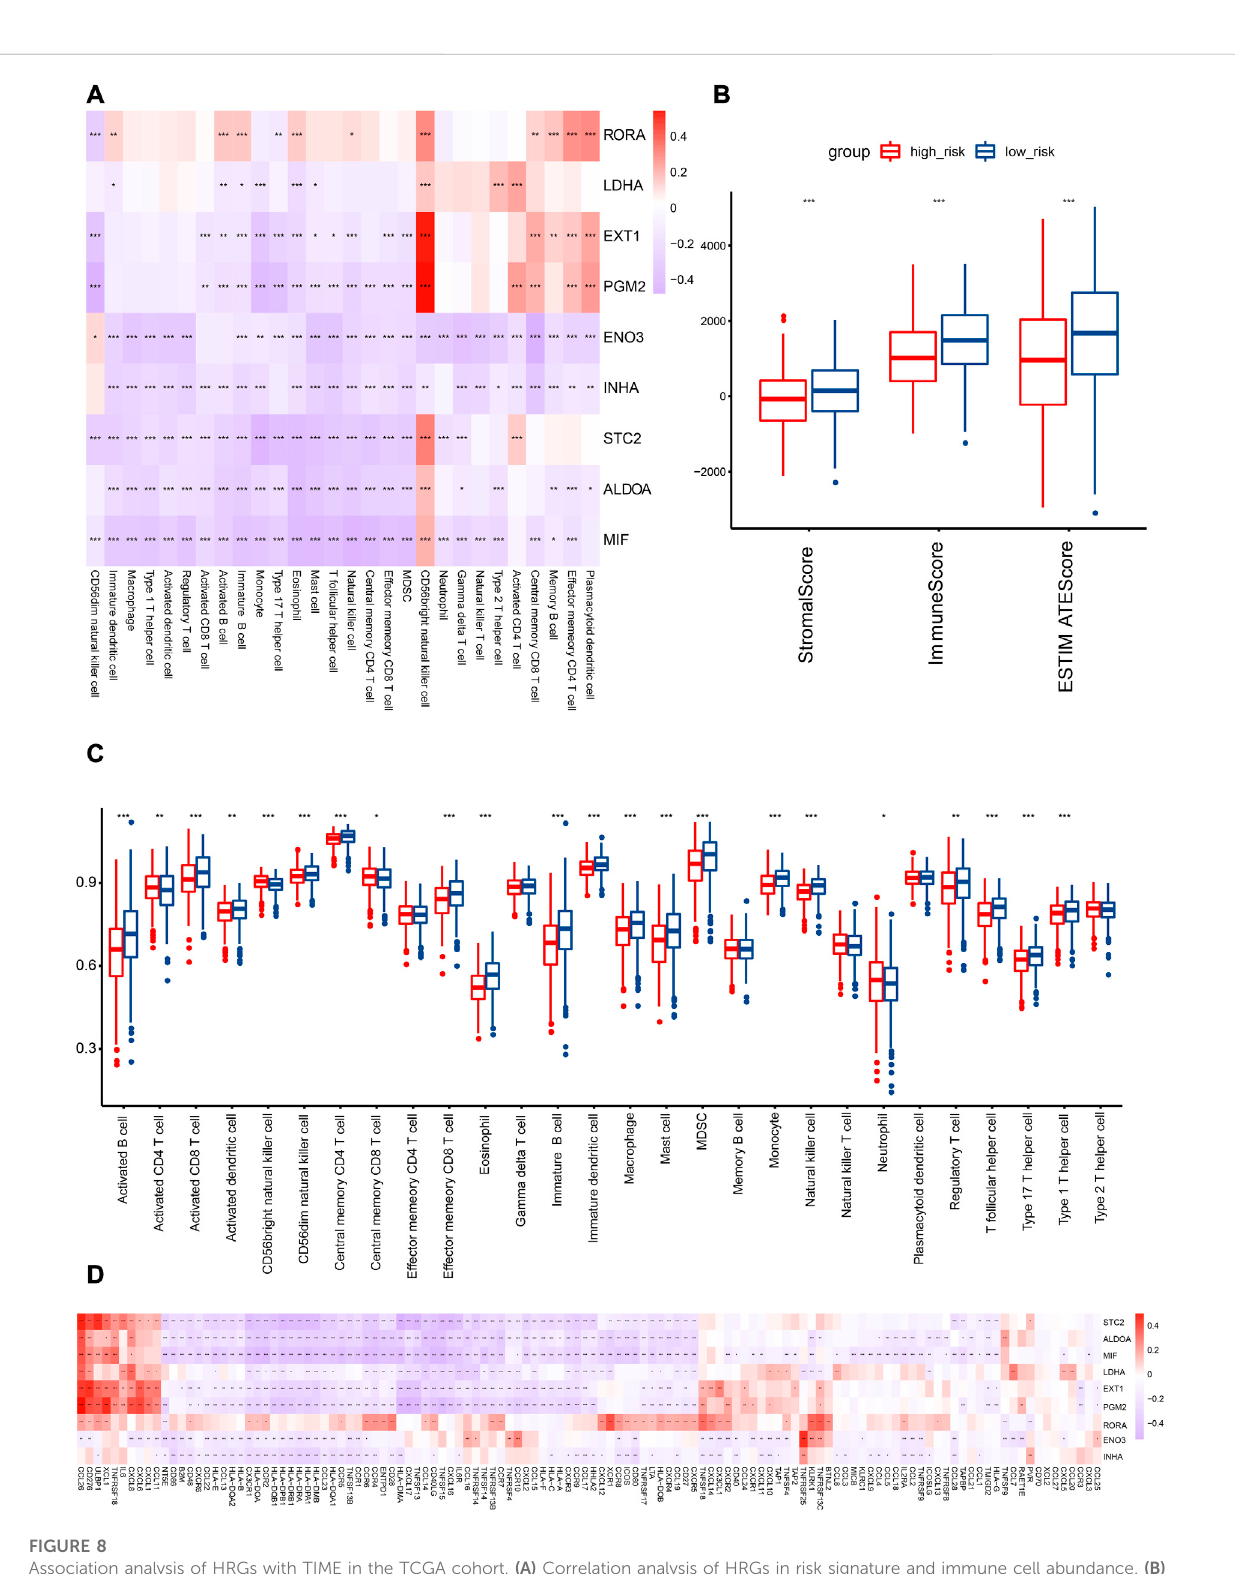
FIGURE 8 Association analysis of HRGs with TIME in the TCGA cohort. (A) Correlation analysis of HRGs in risk signature and immune cell abundance. (B) Comparison of immune score in the two subcategories. (C) Quantitative analysis of immune cell abundance between patients in the two risk categories. (D) HRGs and immunomodulator-related gene correlation analysis. Red represents a positive correlation, while blue represents a negative correlation in the heatmap. * p < 0.05; ** p < 0.01; *** p <